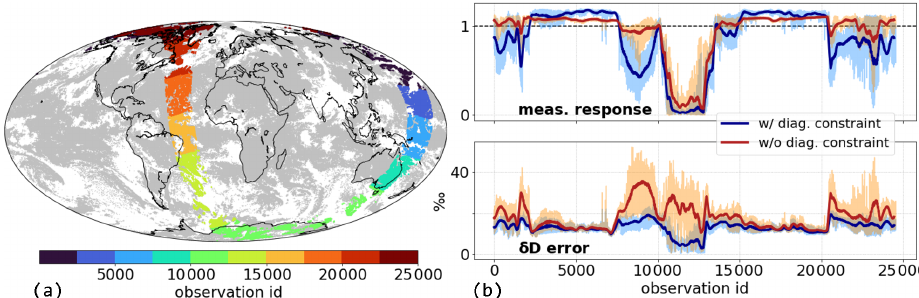
Figure 4. Time series of different retrieval metrics of observations along the Metop-A orbit 55524. Panel (a) shows the location of the observations along the orbit and colour-coded with the chronological observation numbering for this orbit (observation IDs). The grey scatter illustrates all cloud-free Metop-A and Metop-B observations for 1 July 2017 that were considered for the {H 2 O, δ D} pair post-processing. Panel (b) indicates the time series of the measurement response for the {H 2 O, δ D} pairs (upper panel) and the total δ D error (lower panel), both for 4.2kma . s . l . Results for the original product and the product after reducing the retrieval constraint are shown in blue and red, respectively. The solid lines are running means over 200